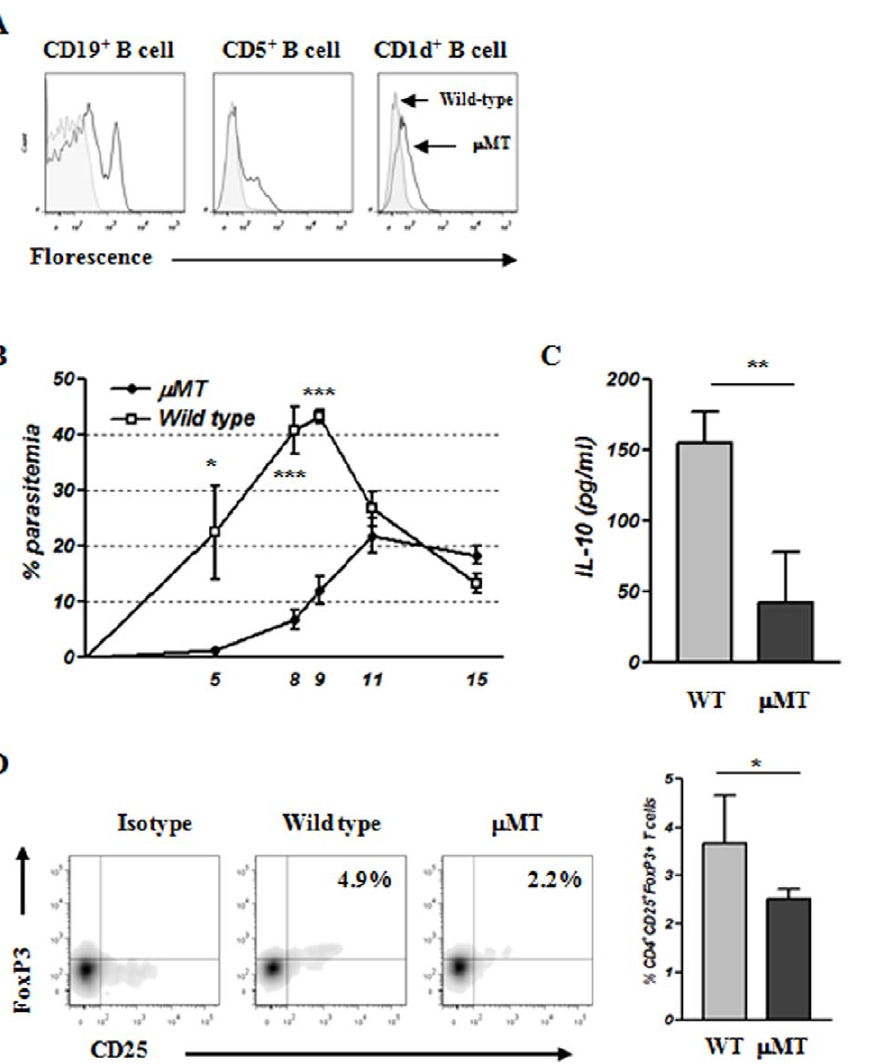
Figure 8. Lack of IL-10-producing B cells moderates the susceptibility to parasitic infection and induction of CD5 + CD25 + FoxP3 + T cells. (A) Identification of CD19, CD5, and CD1d expression in C57BL/6 m MT and C57BL/6 wild-type mice by flow cytometric analysis. The solid gray and white histograms represent wild-type and m MT mice respectively. (B) C57BL/6 m MT and C57BL/6 mice were inoculated with B. microti . Representative parasitemia profiles of both mouse strains throughout the 15 days of parasite infection are presented. (C) Blood was collected from wild type mice and m MT mice on final day of experiment. The production of IL-10 in mice after infection with B. microti was determined. (D) Comparison of CD5 + CD25 + FoxP3 + T cells in m MT and wild-type mice. CD5 + CD25 + FoxP3 + T cells in m MT and wild-type mice as determined by flow cytometric analysis. The frequency of CD5 + CD25 + FoxP3 + T cells was lower in m MT mice than in wild-type mice (right panel). Representative flow cytometric data from one experiment are shown. The results were comparable in two independent infections. The results are expressed as mean values 6 standard deviation of five mice per group. Asterisks indicate statistically significant differences between wild-type versus m MT mice; * P , 0.05, ** P , 0.01, and *** P ,